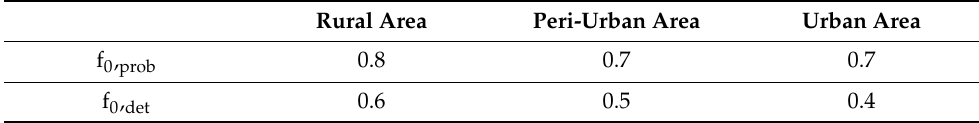
Table 5. Probabilistic design factor f 0 , prob and, deterministic design factor f 0 ,